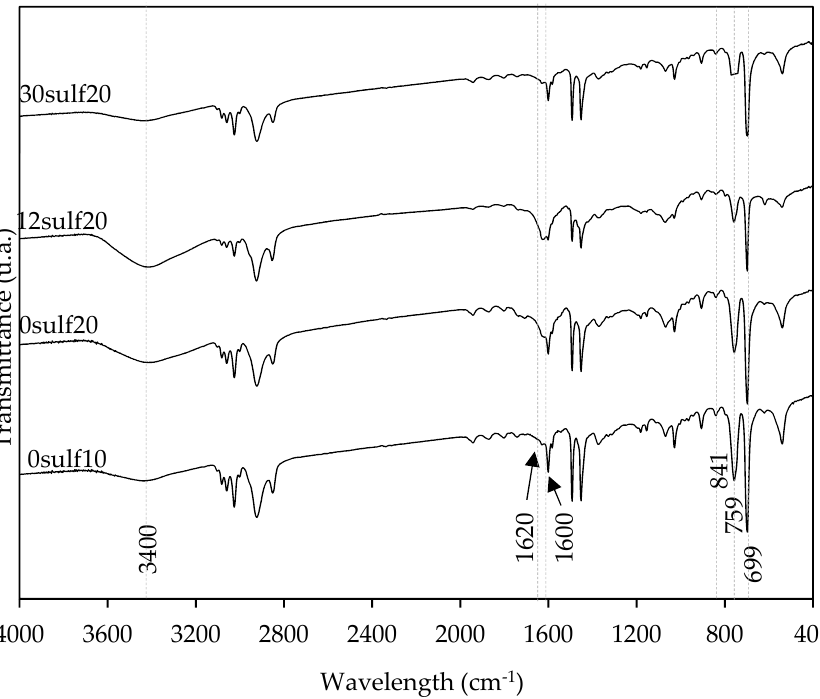
Figure 8. Polystyrene nanoparticles FTIR spectra with different OADA and sulfonate contents: 30sulf20, 12sulf20, 0sulf10 and 0sulf20, whose polymerization formulations are described in Table 1.